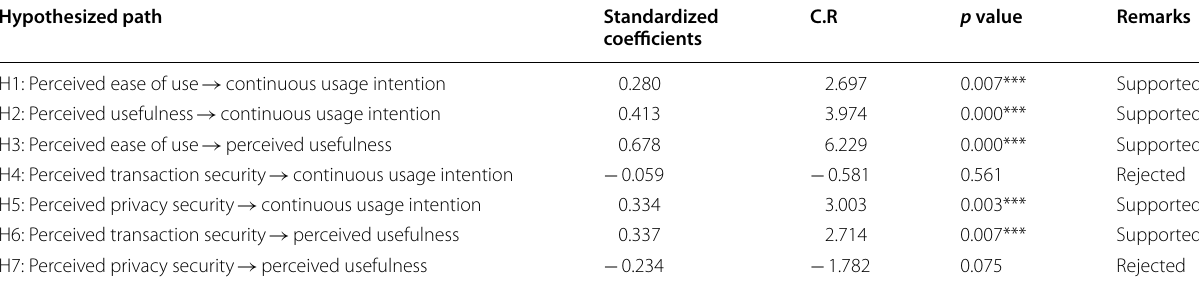
***Suggests that the standardized path coefficient is significant at the 0.01 level